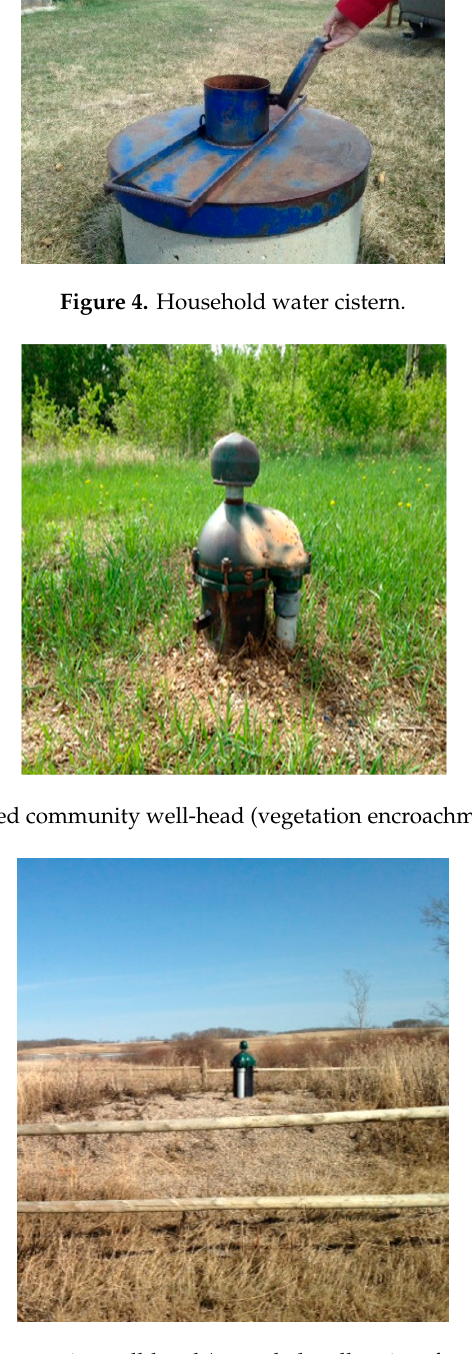
Figure 6. Protected community well-head (extended well casing, fence, gravel mounding).